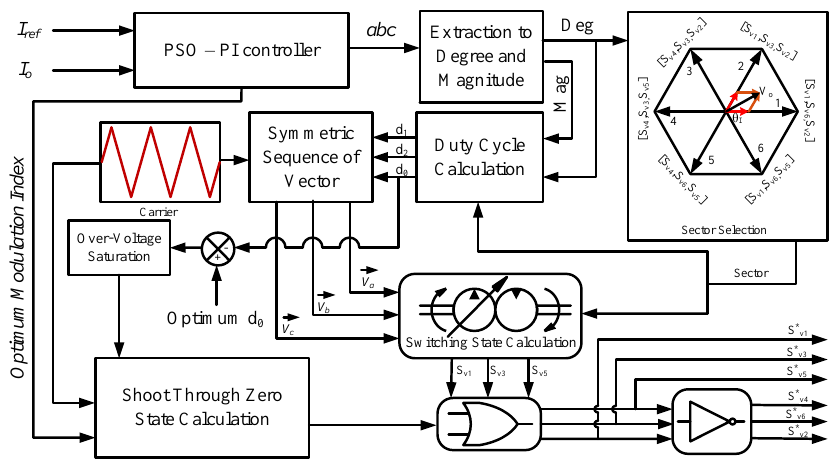
Figure 4. Proposed Voltage Source inverter (VSI) control